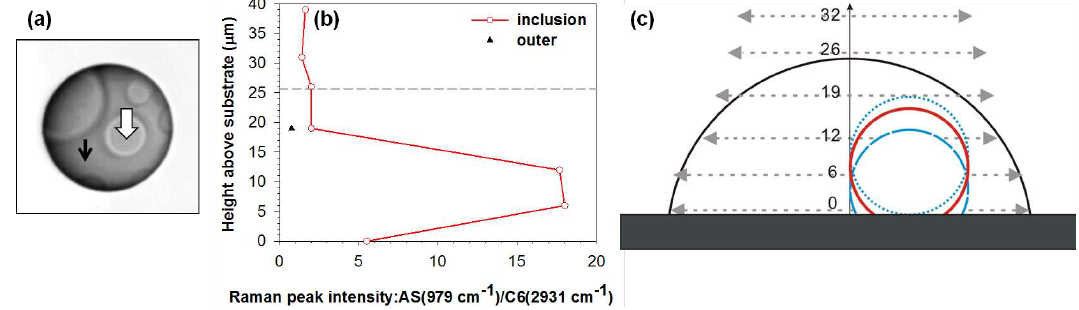
Fig. 10. Raman scan through a C6/AS/H 2 O droplet with OIR=1:1 on the hydrophobic coated substrate at 65%RH. Panel (a) : optical image of the droplet (58.9µm in diameter). The white arrow indicates the position of the Raman scan through the AS inclusion ( ∼ 19.0µm in diameter). Panel (b) : ratios of AS (979cm − 1 ) and C6 (2931cm − 1 ) Raman peak intensities. Red circles: vertical scan through the droplet at the position indicated by the white arrow in (a) . Black triangle: reference point representing the AS/C6 Raman ratio of the outer phase measured at the position indicated by the black arrow in the (a) . The gray dashed line sets the maximum height of the droplet (25.4µm) as reconstructed in panel (c) . Panel (c) : reconstructed side view of the droplet (black curved line) on the substrate and the inclusion (red) indicated by the white arrow in panel (a) . In blue are shown inclusions with upper and lower limits of the estimated contact angle range from 105 to 140 ◦ . The horizontal gray arrows correspond to the particle diameter (µm) measured from the microscopic images at each scanning level of the droplet (red open circles in panel b